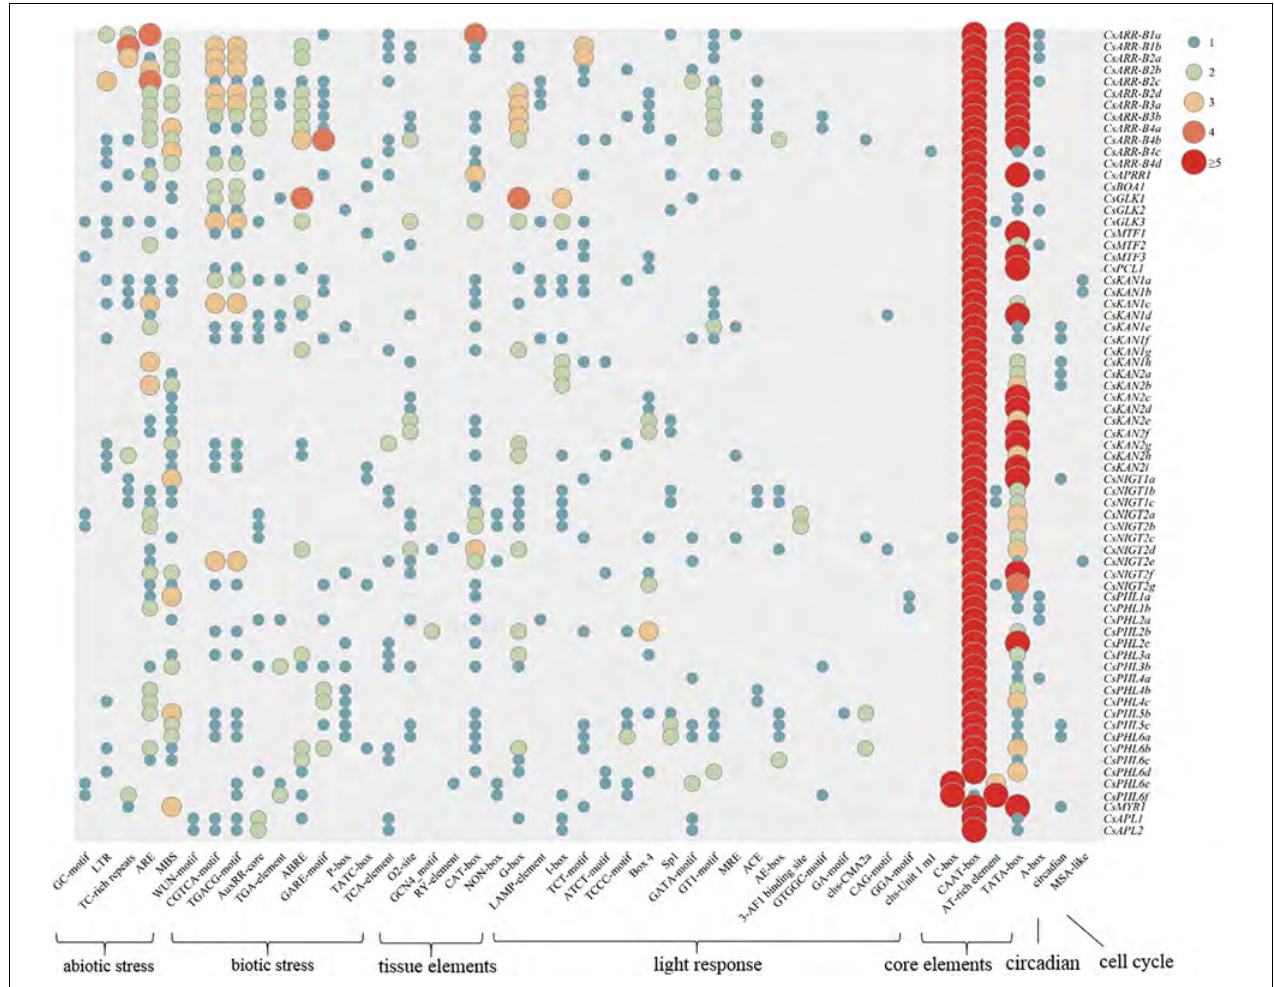
FIGURE 7 | Analysis of cis -acting elements of 69 CsGARP genes. The cis -acting elements were classified into 7 types: abiotic stress-responsive elements, biotic stress-responsive elements, tissue-specific expression elements, light-responsive elements, core promoter elements, circadian elements and cell cycle elements.